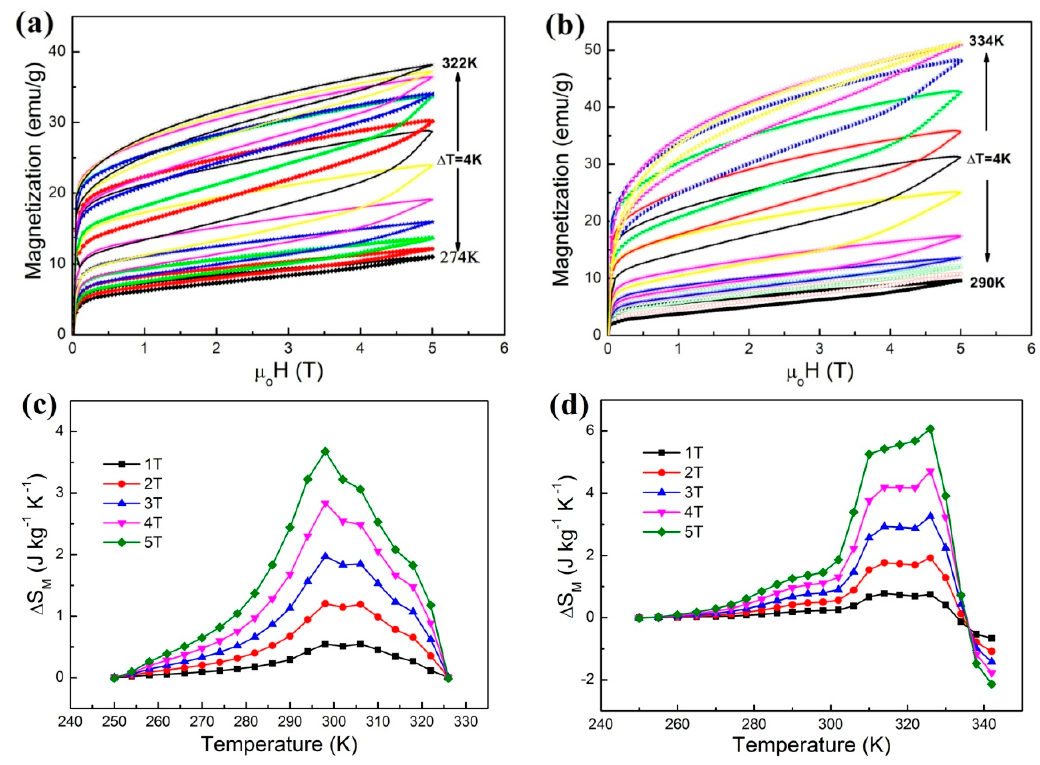
Figure 6. ( a ) Isothermal magnetization curves for the melt-spun ribbons; ( b ) Isothermal magnetization curves for the annealed ribbons; ( c ) ∆ S M as a function of temperature change under various field changes for melt-spun ribbons; ( d ) ∆ S M as a function of temperature change under various field changes for annealed ribbons.